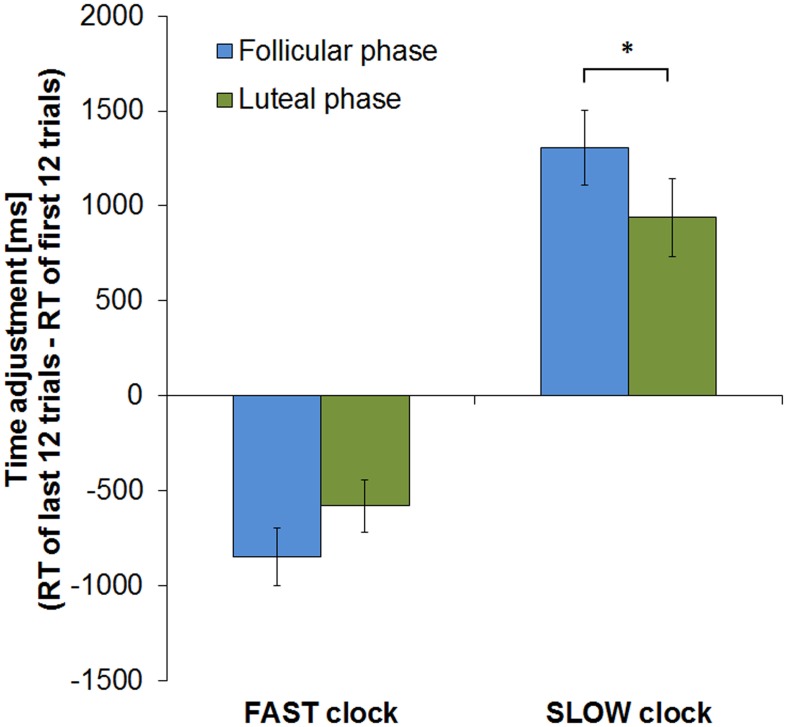
RT change from first to last block of the clock task in both cycle phases. In both clock conditions subjects showed greater RT change in the course of the experimental run during the FP (*p < 0.05). Error bars represent standard error of the mean (sem).